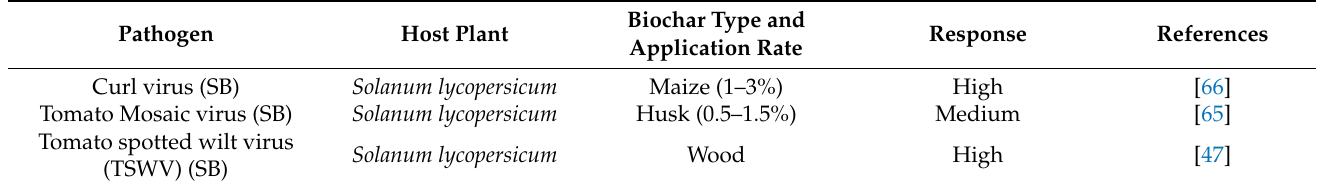
Table 4. List of experimental studies that applied biochar as a soil amendment to control plant diseases caused by viral plant pathogens. Pathogen, host plant, biochar feedstock type, response level, and reference are reported for each